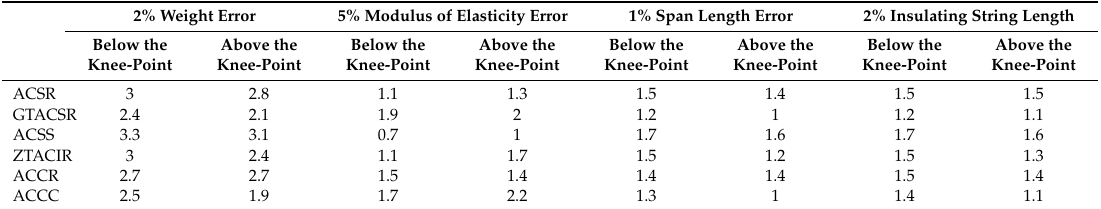
Figure 6. Equivalent CTE error of a GTACSR (Gap Type Thermal-Resistant Aluminum Alloy Conductor Steel Reinforced) conductor above and below the knee-point. ( a ) 2% weight error; ( b ) 5% modulus of elasticity error; ( c ) 1% span length error; ( d ) 2% insulating string length. Table 5. Equivalent CTE errors for di ff erent HTLS